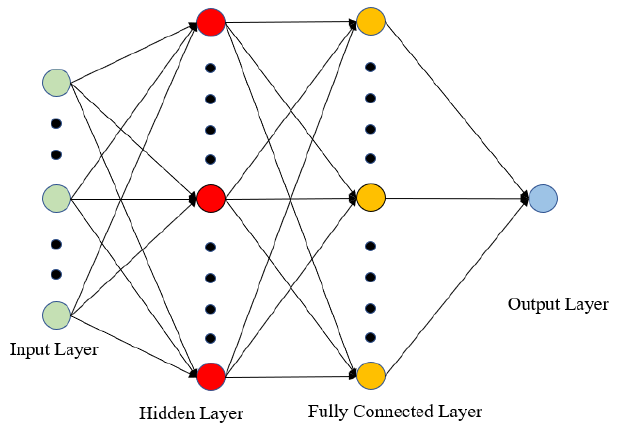
Figure 2. LSTM-FC model structure diagram.